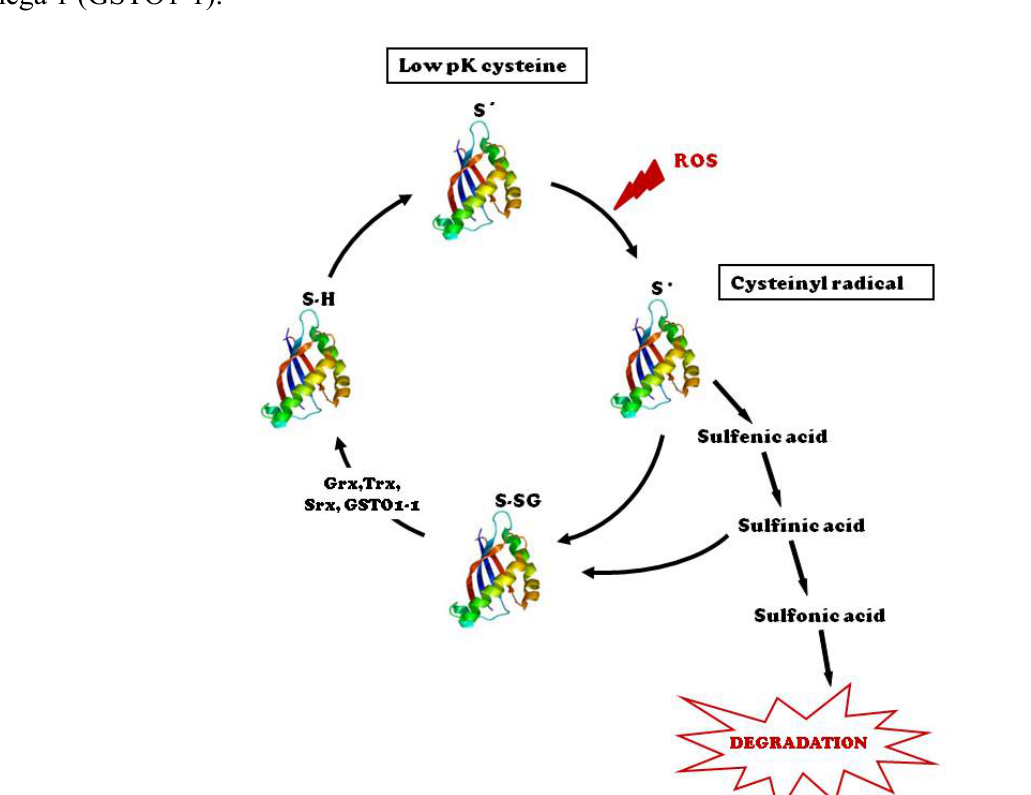
Figure 1. S -glutathionylation cycle. Low pKa cysteine residues of proteins are targets for S -glutathionylation under oxidative stress conditions. The cysteine residue is first oxidized to form protein sulfenic acids through the formation of a protein cysteinyl radical. Sulfenic acids are highly unstable, undergoing further oxidation to sulfinic and sulfonic acids. Protein sulfonic acids are susceptible to degradation, whereas both cysteinyl radical and sulfenic acid can be conjugated to GSH to form glutathionylated proteins (PSSG). S -glutathionylation can be reversed by various enzymes, such as thioredoxin (Trx), glutaredoxin (Grx), protein disulfide isomerase (PDI) and glutathione transferase omega 1